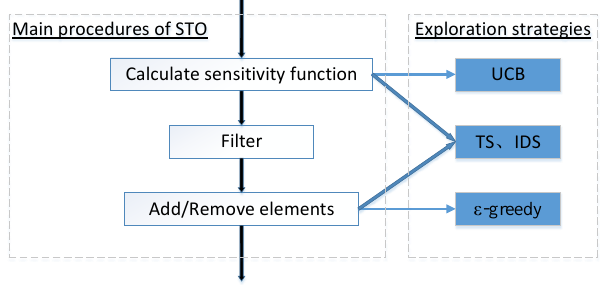
Figure 2. General workflow.